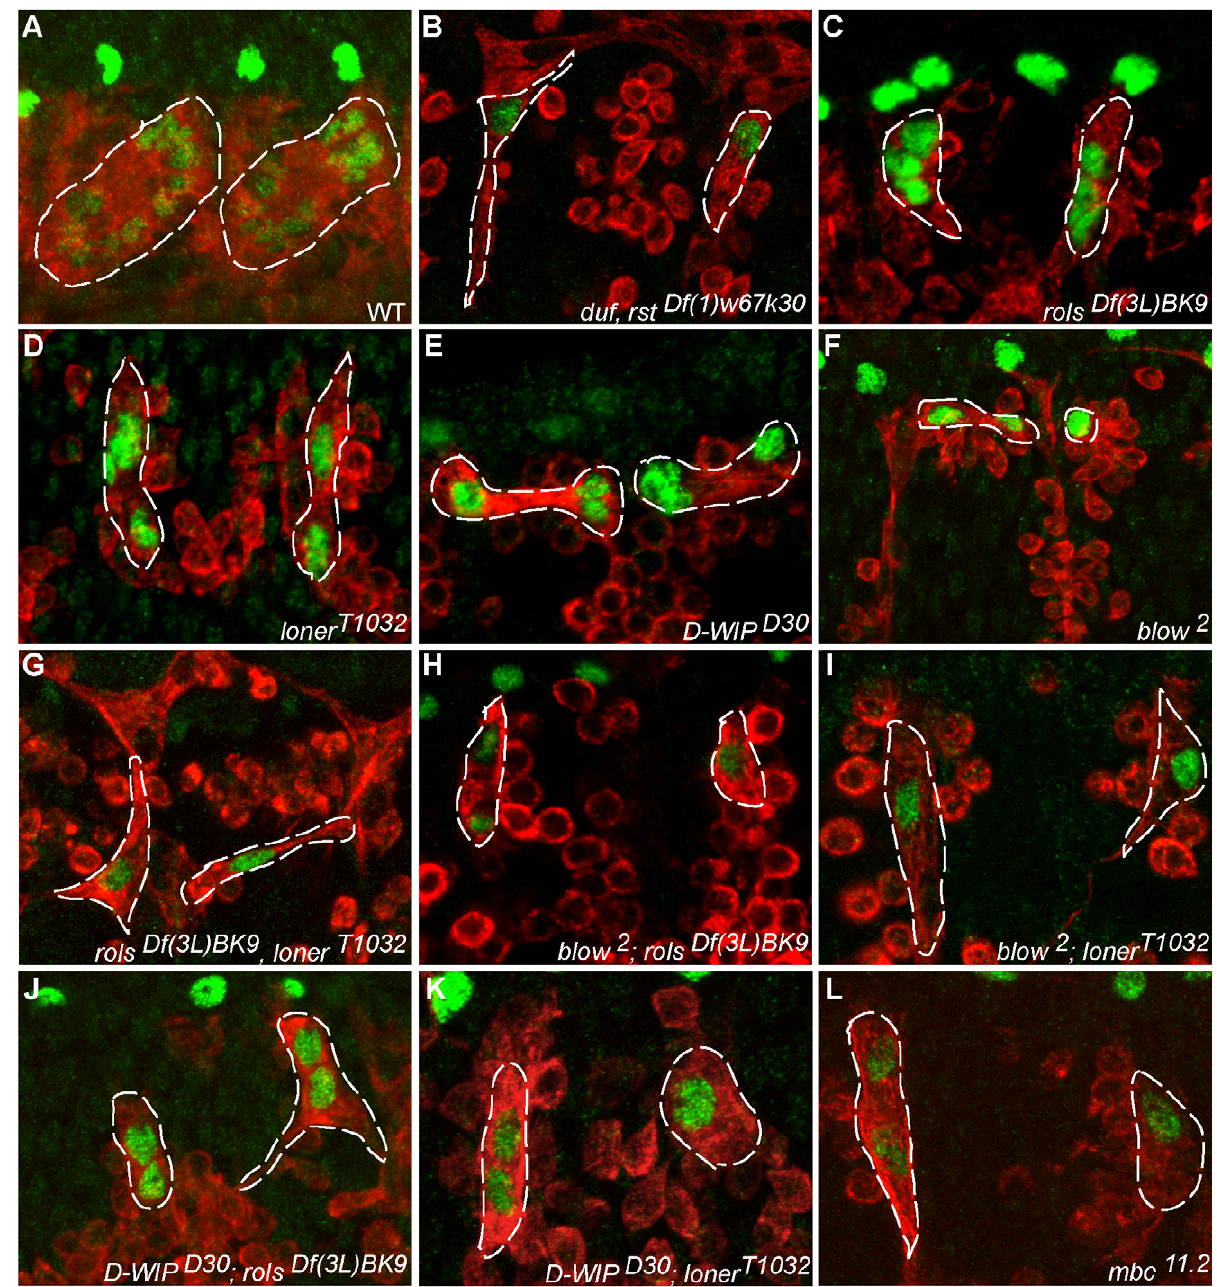
Figure 5. Fusion in single and double mutant backgrounds. Late stage 15-early stage 16 embryos with somatic muscles and FCM labelled with anti-MHC (red) and anti-eve (green). Wild type DA1 muscle with approximately 10 nuclei per muscle (A). duf, rst embryos with uninucleate DA1 muscles (B). rols , loner , D-WIP , blow and mbc single mutants (C–F and L). (G–K) rols,loner , blow;rols , blow;loner , D-WIP;rols and D-WIP;loner double mutants with reduced number of eve positive nuclei. The pericardial cells are also labelled with anti-eve but are distinguished by their brighter stain and are not surrounded by MHC positive muscle cytoplasm.